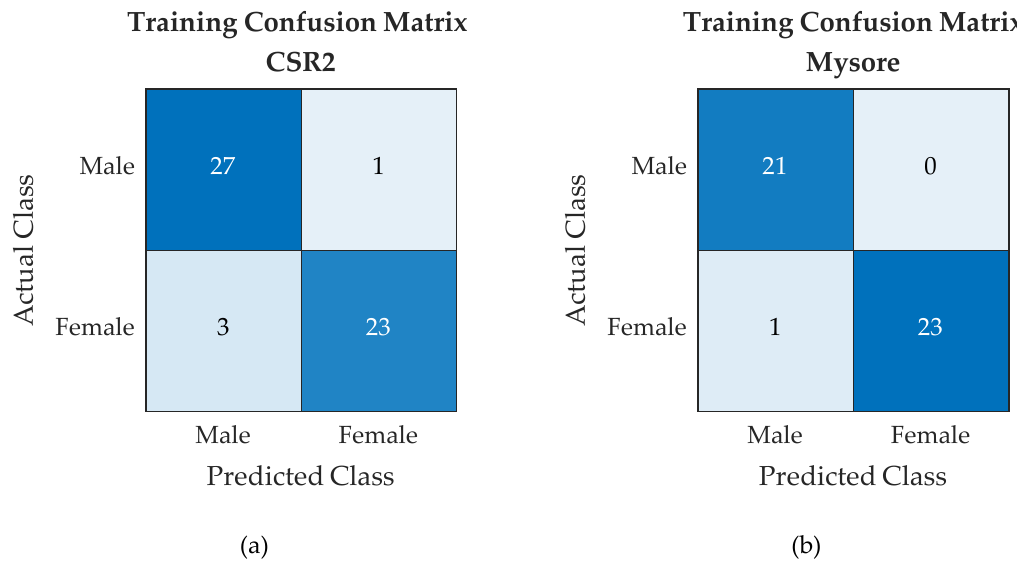
Figure 13. SVM training confusion matrices for CSR2 ( a ) and Pure Mysore cocoons ( b ).